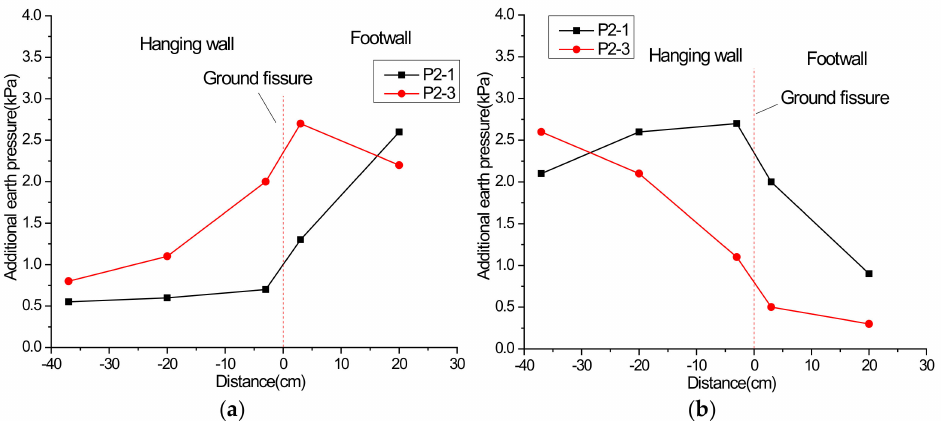
Figure 17. Additional earth pressure at 50 cm height under the scenario of inactive ground fissure: